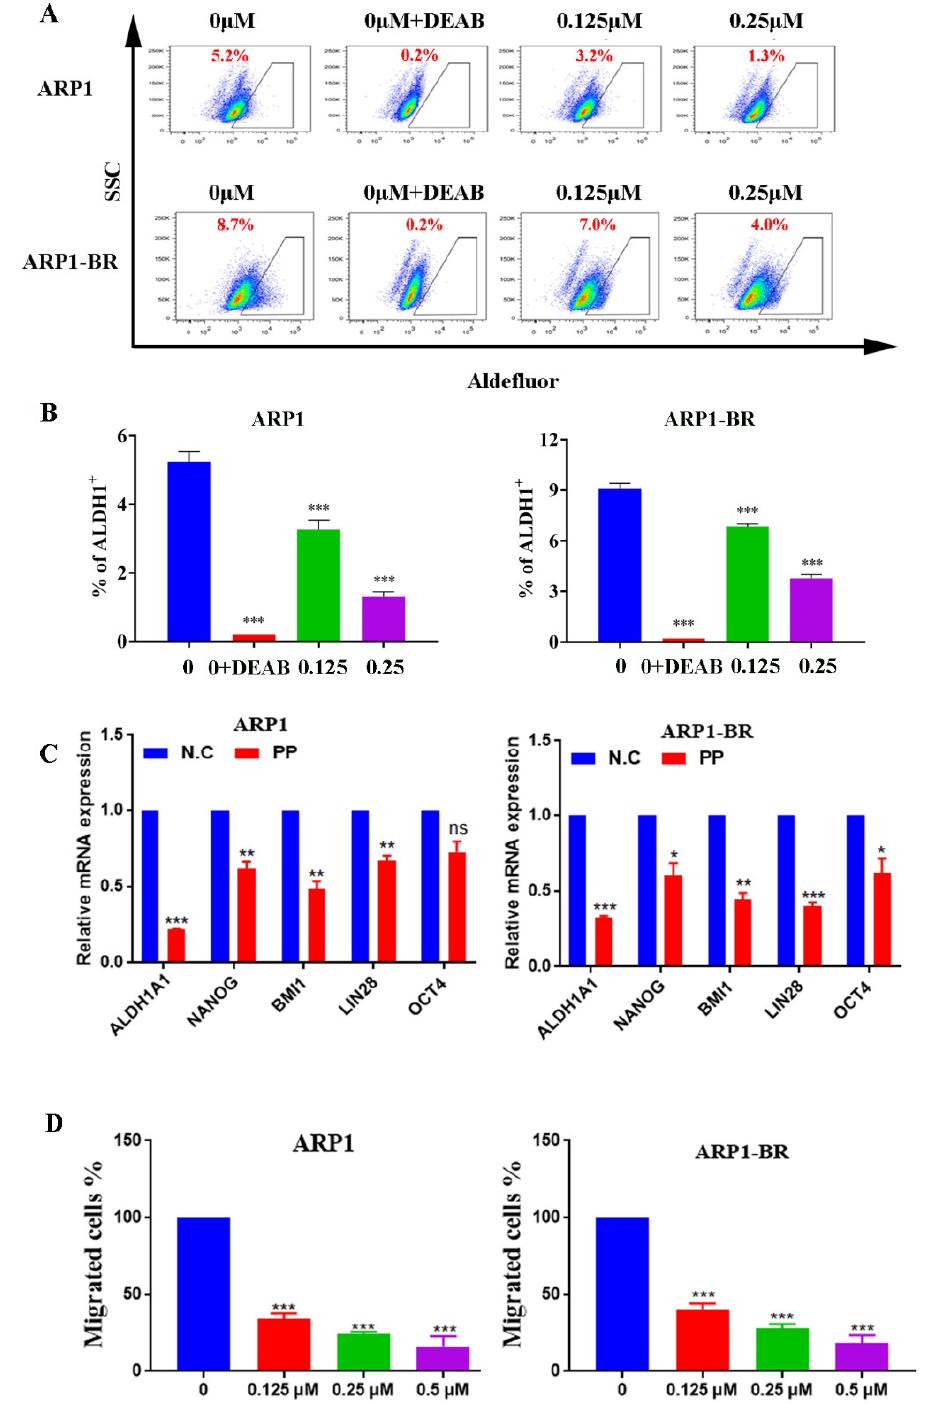
Figure 3. Periplocin suppresses the stemness and cell migration of MM cells. ( A ) Detection of changes in ALDH ratio of ARP1 and ARP1-BR cells by aldefluor assay after PP treatment at mentioned concentrations for 24 h, the gate of the experimental group was determined by using DEAB was used as a control strain. ( B ) Bar graph representation of the decreased ALDH ratio of ARP1 and ARP1-BR cells by PP treatment. ( C ) Detection of downregulation in the expression of ALDH1A1 gene and iPSC genes by qRT-PCR after PP treatment at mentioned concentrations for 24 h. Expression of genes in cells with at 0 μM PP treatment was set to 100%. ( D ) The effect of PP on cell migration ability of ARP1 and ARP1-BR cells through transwell assay at mentioned concentra- tions for 24 h. The number of migrated cells of 0 μM PP-treated cells was set to 100%.The bar graphs demonstrated a mean ± SD of three independent experiments. The results were considered